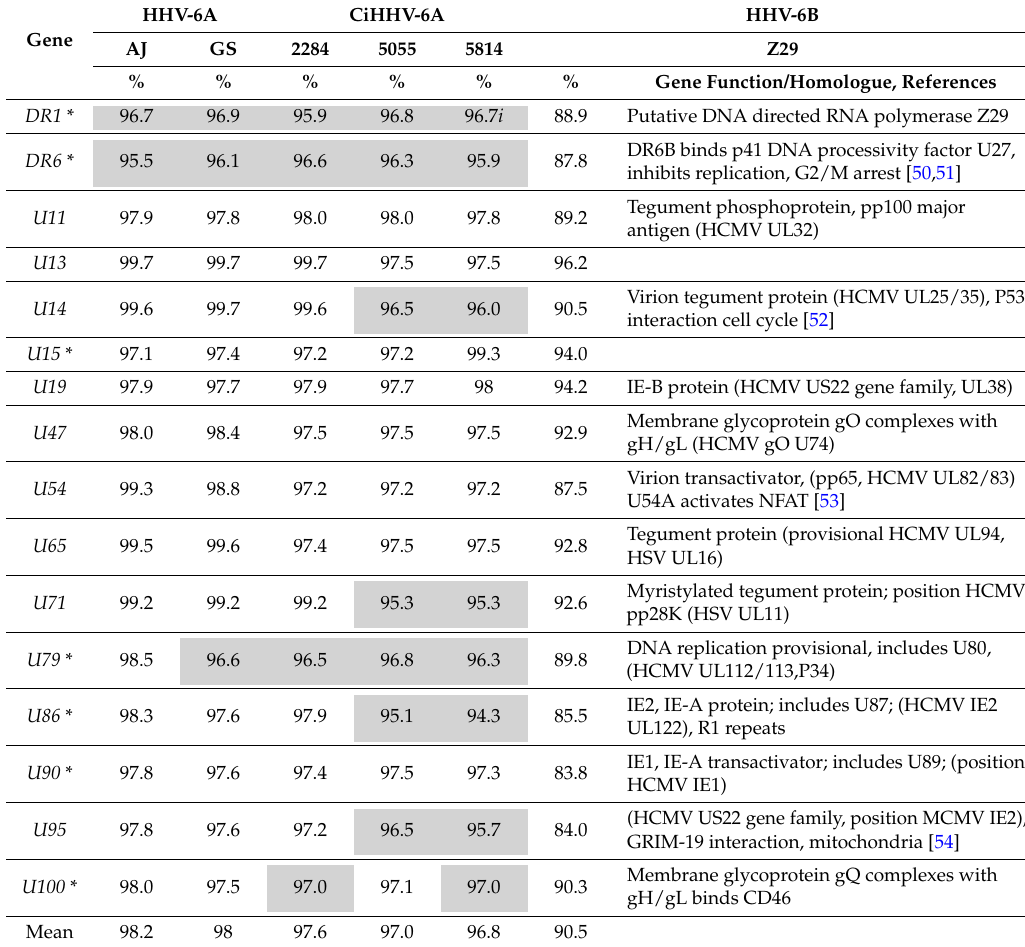
+Genes were translated, aligned by Muscle, phylogenetic analyses of nucleotide sequence using Bestfit model with maximum likelihood analyses (Tamura-3-parameter with Gamma distribution, HK or GTR) and then pairwise distance analyses with <98% cut-off compared to CiHHV-6A genes using Mega5.1 as compared to orthologues in HHV-6A/B. * HHV-6A defined splice donors and acceptors as annotated used to generate spliced products. i = partial, exon2 DR6. Shaded scores show <97% cut off. Functions/homologues/references from genome annotations and cited. Brackets show homologues in other